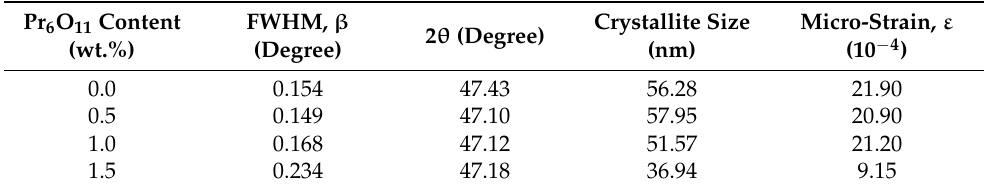
Table 3. Variation of FWHM value, crystallite size and micro-strain ( ε ) of Pr-doped ZnO-BaTiO 3 varistor ceramics with different content.